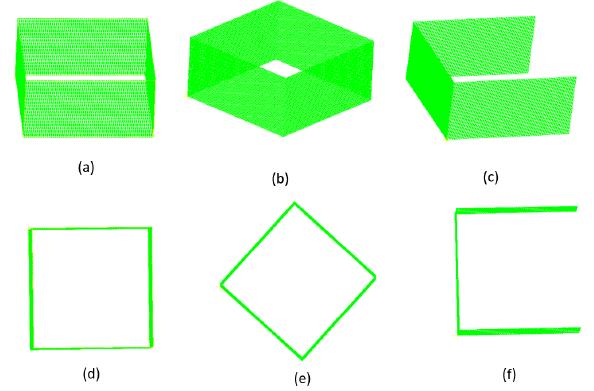
Figure 2: Models M 1 , M 2 and M 3 , from left to right. The top and bottom rows show the sideview and topview of the models respectively (the same below in this paper).